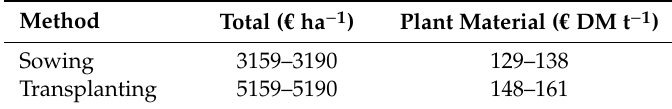
Table 10. Cost comparison of planting vs. direct sowing of S. perfoliatum (Biertümpfel and Conrad 2013, cited in